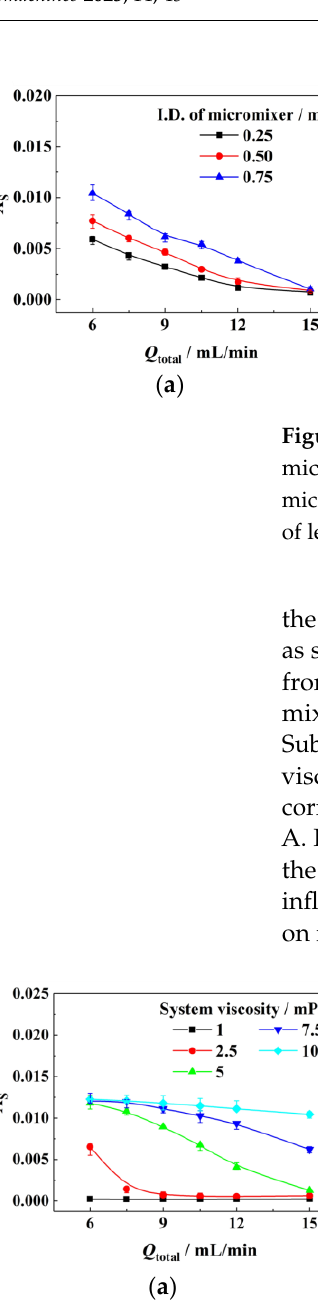
Figure 4. Influence of fluids characteristics on micromixing performance: ( a ) bulk viscosity, ( b ) con- tinuous fluid viscosity, and ( c ) dispersed fluid viscosity. Reference conditions: micromixer, 0.25 mm of I.D.; connecting pipe, 0.5 mm of I.D., 5 cm of length; micropacked bed, 5 cm of length; packing size, 0.177~0.250 mm; Q A : Q B = 5:1. ( a ) μ A = μ B , ( b ) μ B = 5 mPa·s, ( c ) μ A = 5 mPa·s.